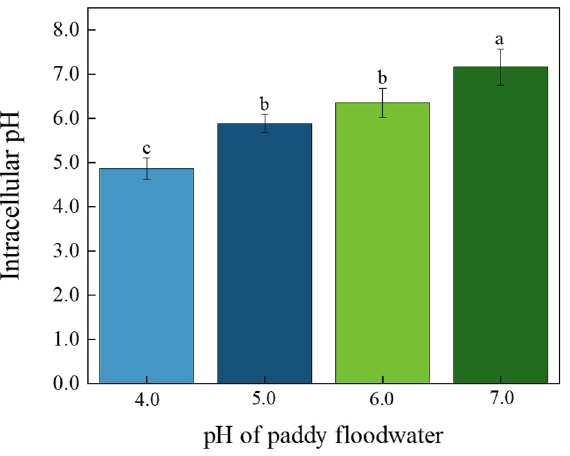
Figure 4. Effects of paddy floodwater acidification on intracellular pH of Aliinostoc sp. YYLX235. Different letters indicate statistically significant at p < 0.05 (one-way ANOVA, LSD).